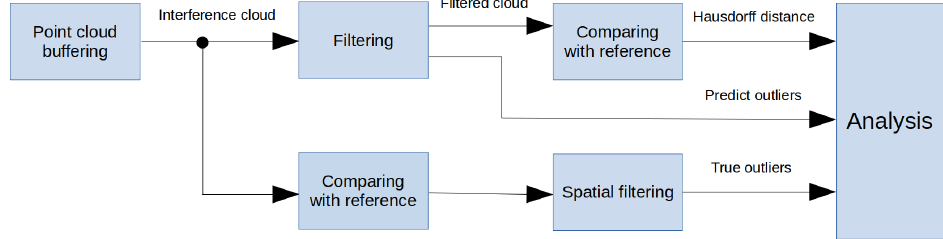
Figure 6. The block diagram of evaluation